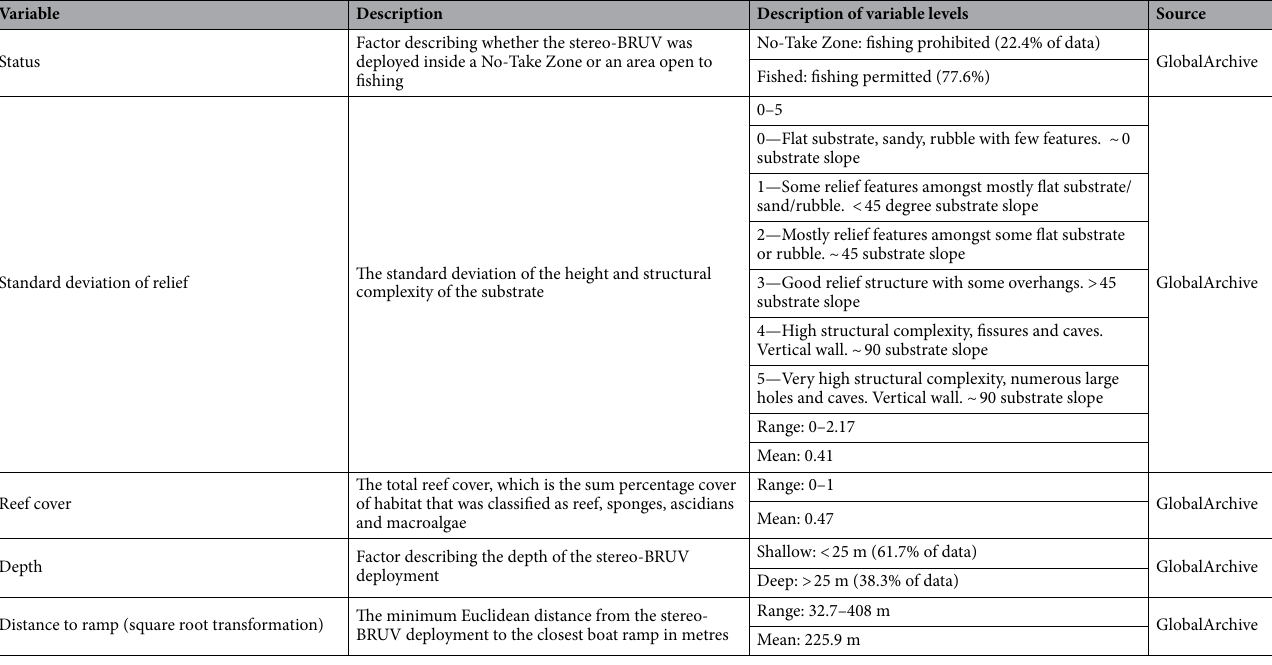
Table 1. Description and summary of the five variables used in analysis.